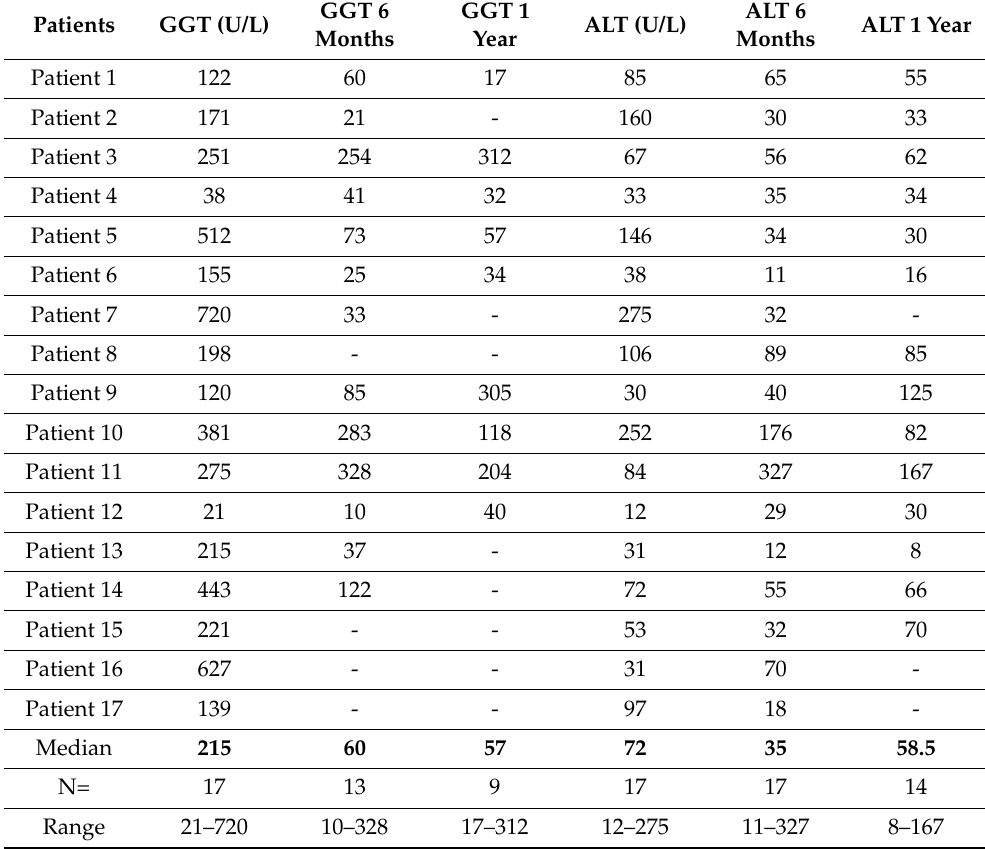
Table 2. Lab parameters (ALT, GGT) pre- and post-oral vancomycin therapy.